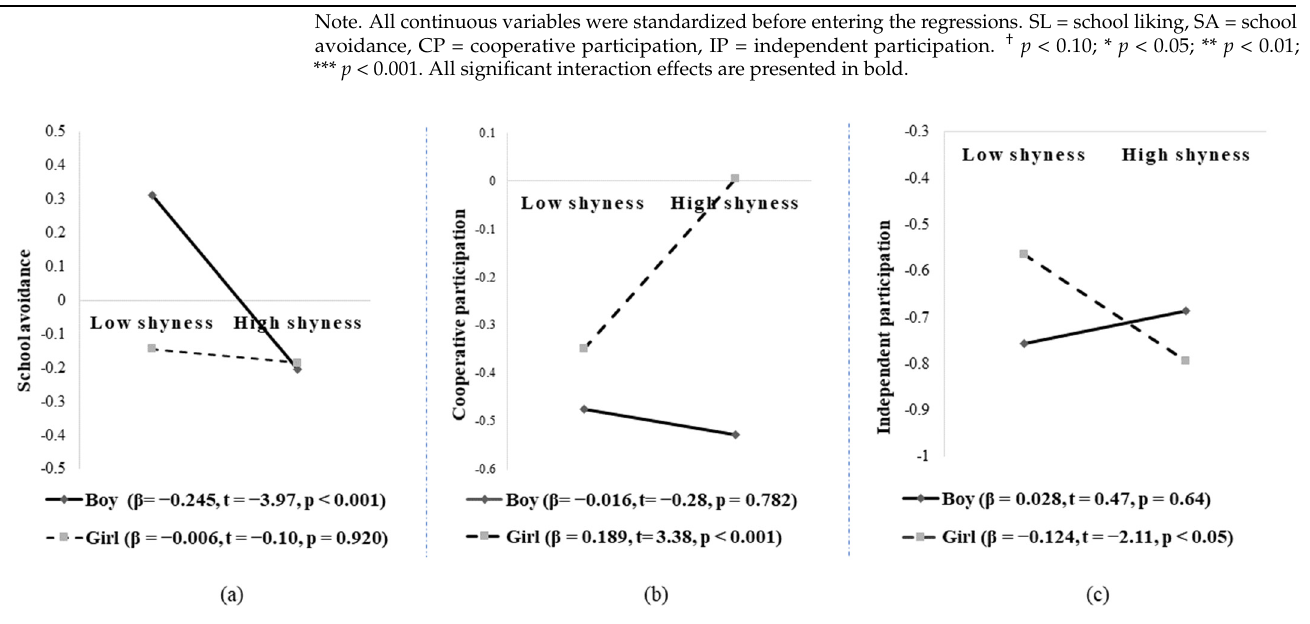
Figure 2. ( a ) Interaction between shyness and gender in predicting school avoidance; ( b ) interaction between shyness and gender in predicting cooperative participation; ( c ) interaction between shyness and gender in predicting independent participation.